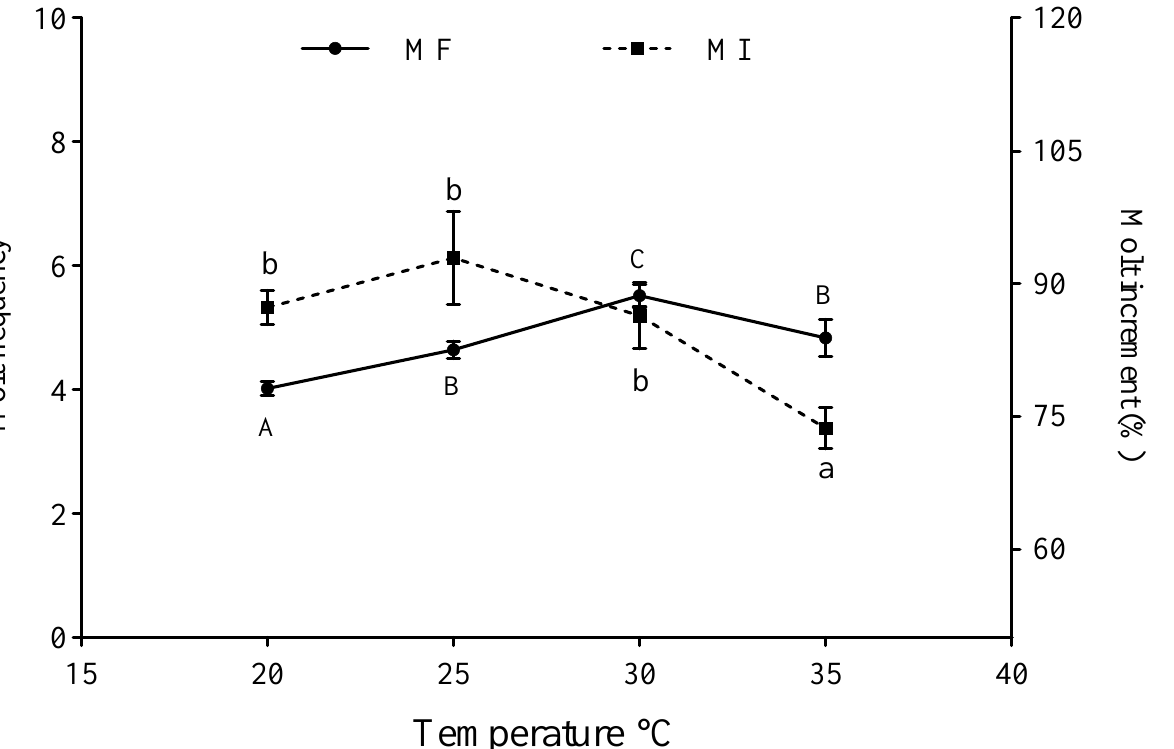
Figure 3. Effects of different temperatures (20–35 ◦ C) on the molt frequency and molt increment of juvenile mud crabs. Values are expressed as mean ± SD ( n = 3). Different superscripts indicate significant differences between treatments ( p < 0.05).